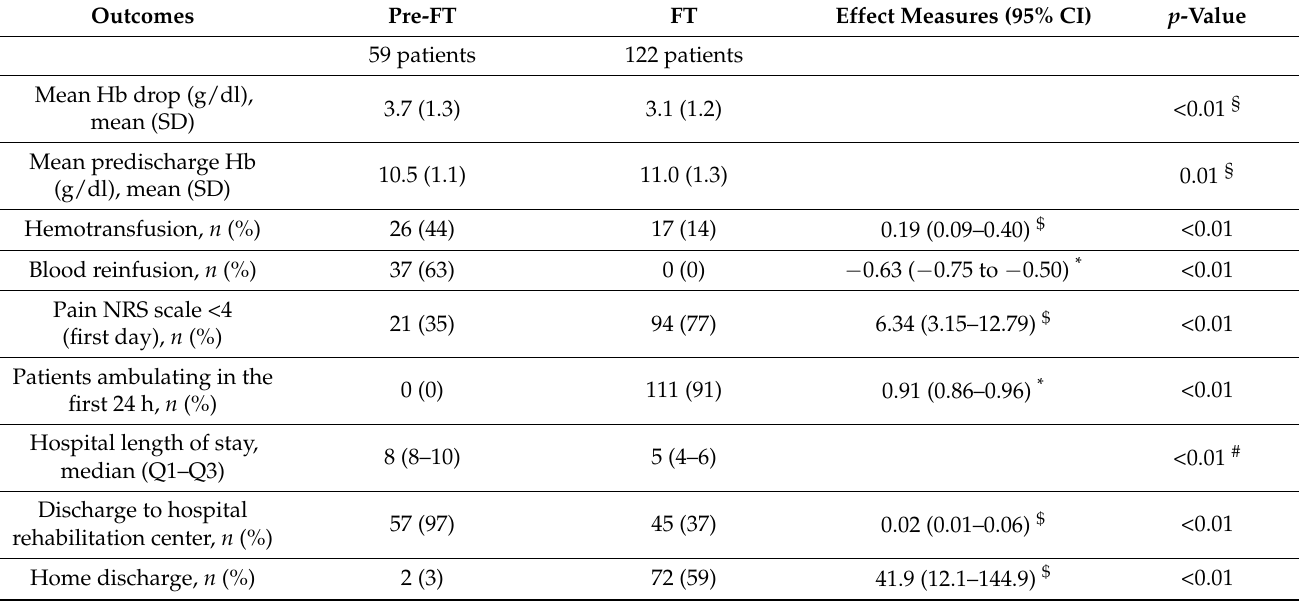
Table 3. Impact of the FT protocol on the outcomes of the two patient